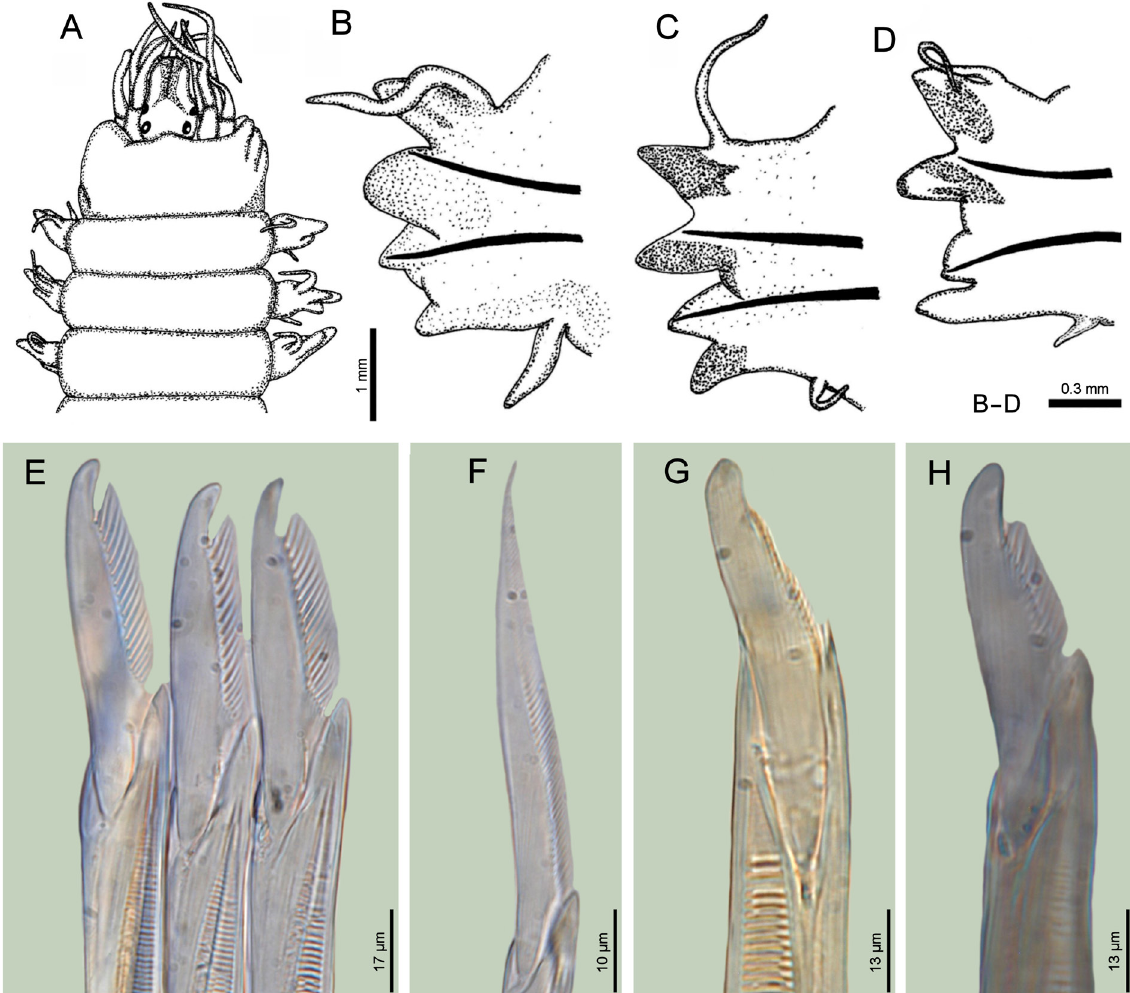
Fig. 10. Nereis riisei Grube & Örsted in Grube, 1857, holotype (NHMD 109270). A . Anterior end, dorsal view. B . Chaetiger 10, right parapodium, anterior view. C . Chaetiger 40, right parapodium, anterior view. D . Chaetiger 60, right parapodium, anterior view. E . Chaetiger 10, heterogomph falcigers. F . Chaetiger 40, heterogomph spiniger. G . Chaetiger 60, homogomph falciger, tip slightly eroded. H . Chaetiger 60, heterogomph